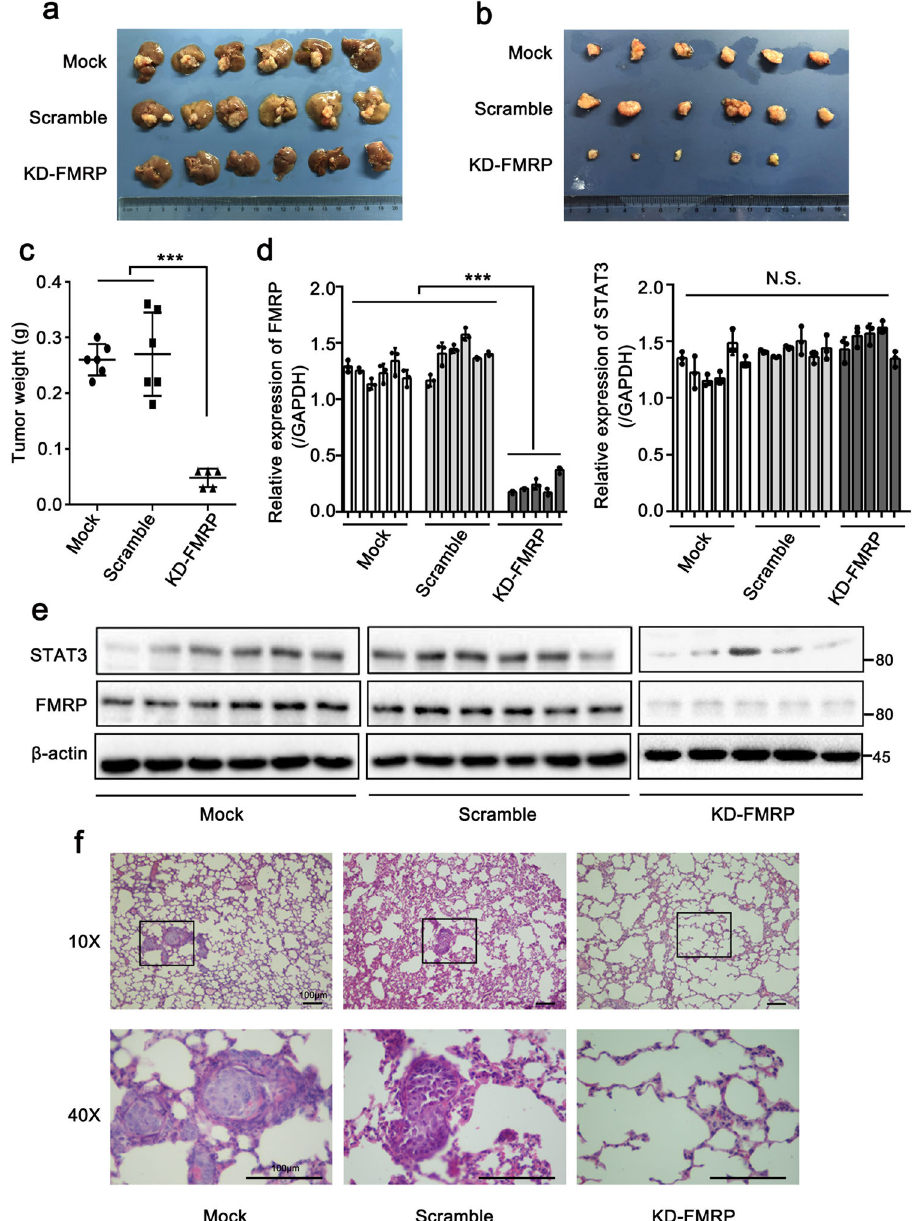
Fig. 6 FMRP knockdown suppresses the metastatic capacity of HCCLM3 in vivo. a Livers injected with FMRP-knockdown cells to form xenograft tumors, accompanied by a scramble and mock groups. n = 6 biologically independent samples (one mouse in the KD-FMRP group did not develop a tumor). b Image of the xenograft tumors stripped from livers in nude mice. c Weights of xenograft tumors in three groups were measured. d , e Q-RCR ( d ) and western blot ( e ) analysis of FMRP and STAT3 expression of the xenograft tumors. The values in the graphs represent the mean of three biologically independent experiments. f Representative H&E staining of metastatic lung nodules at the indicated groups. Scale bar: 100 μ m. Error bars represent